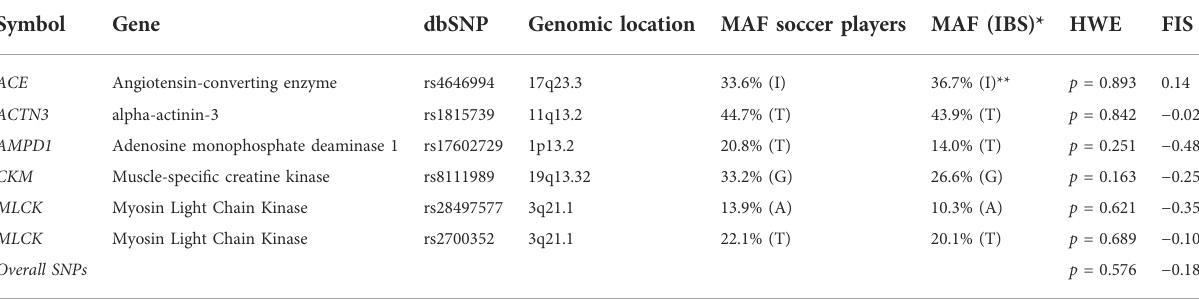
TABLE 2 Genomic location and minor allele frequency (MAF) for selected genes in muscle